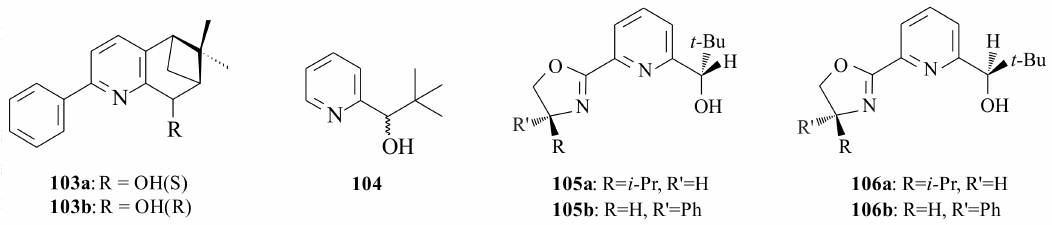
Figure 20. Substituted pyridinyl complexes used as ligands for addition reactions.